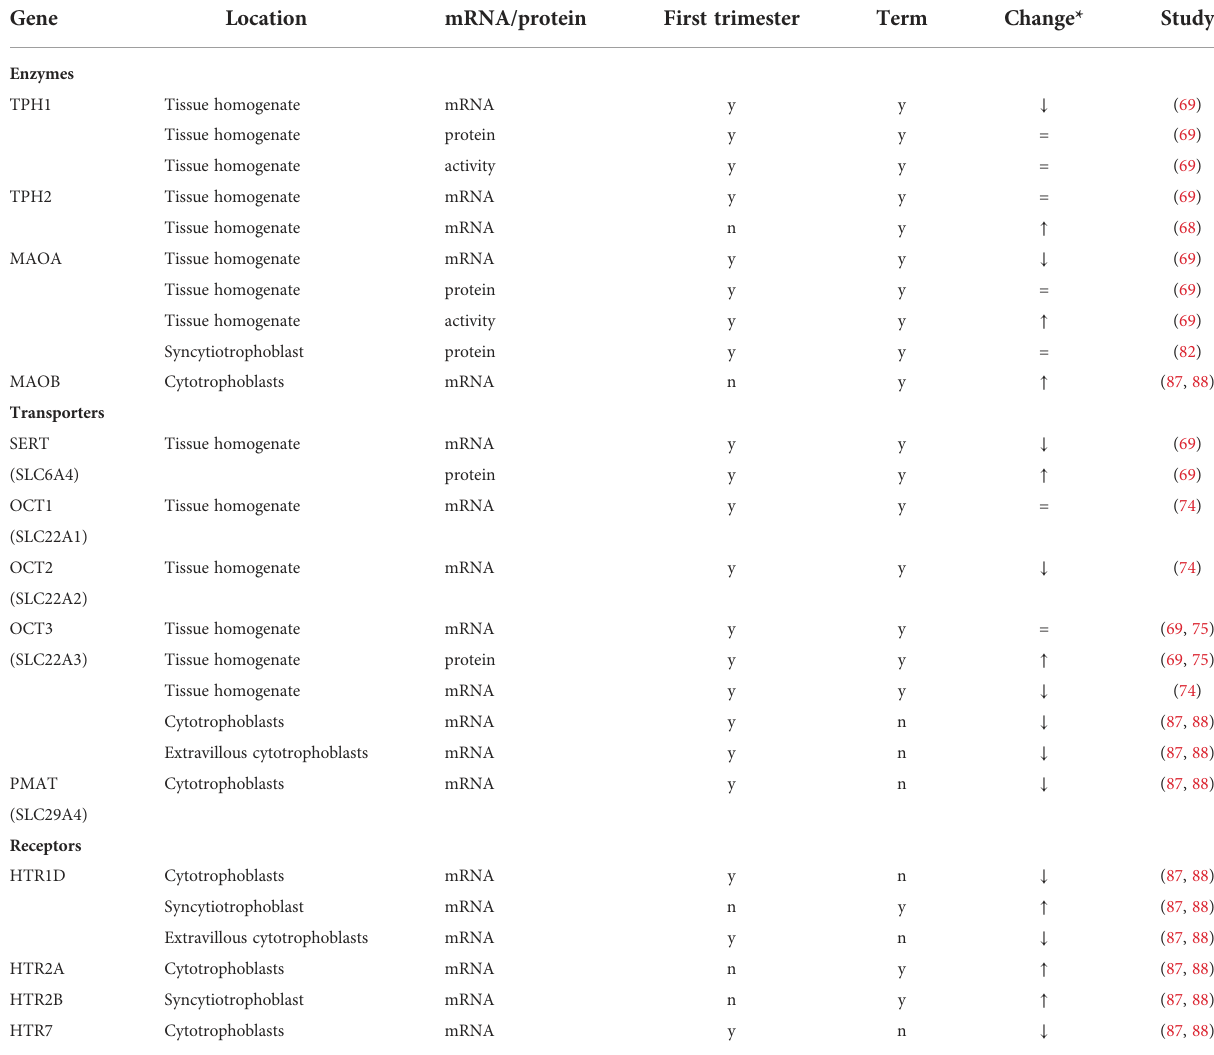
TABLE 4 Changes in the expression of serotonin components in human placenta in the third trimester compared with the fi rst trimester of pregnancy. Gene Location mRNA/protein First trimester Study